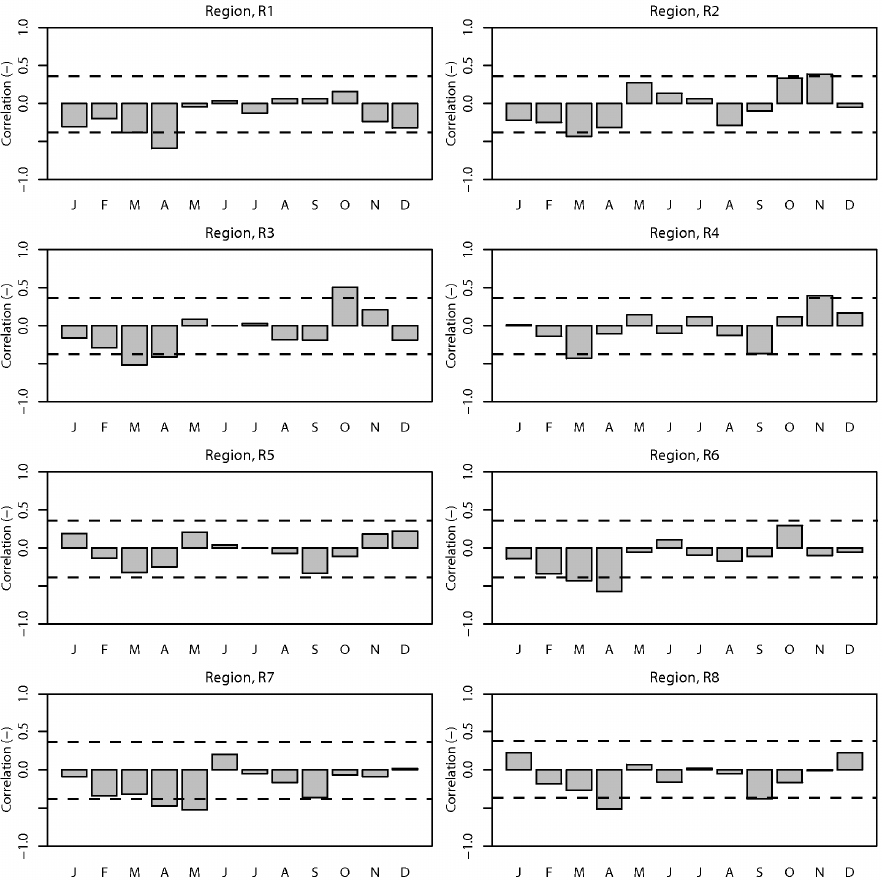
Figure 5. The correlation of concurrent monthly rainfall (mm/month) and Multivariate ENSO Index (MEI) of eight distinct climatic regions. The dotted line indicates significance at 95% level.